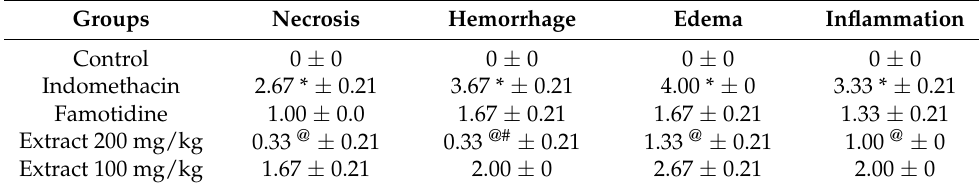
Table 1. Effect of A. anthelmintica extract on gastric damage induced by indomethacin in rats.